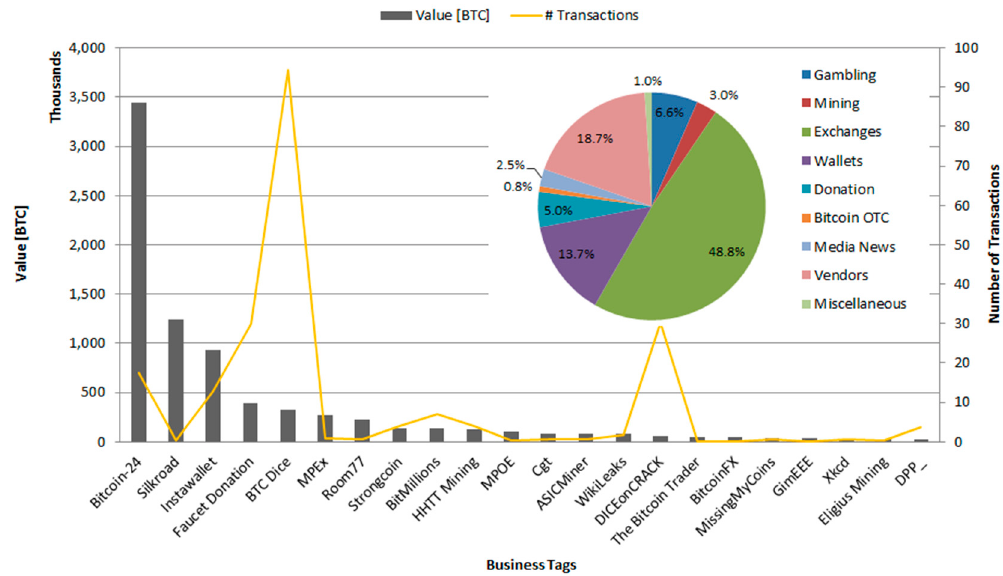
Figure 8. Top 25 Businesses (Value in BTC).